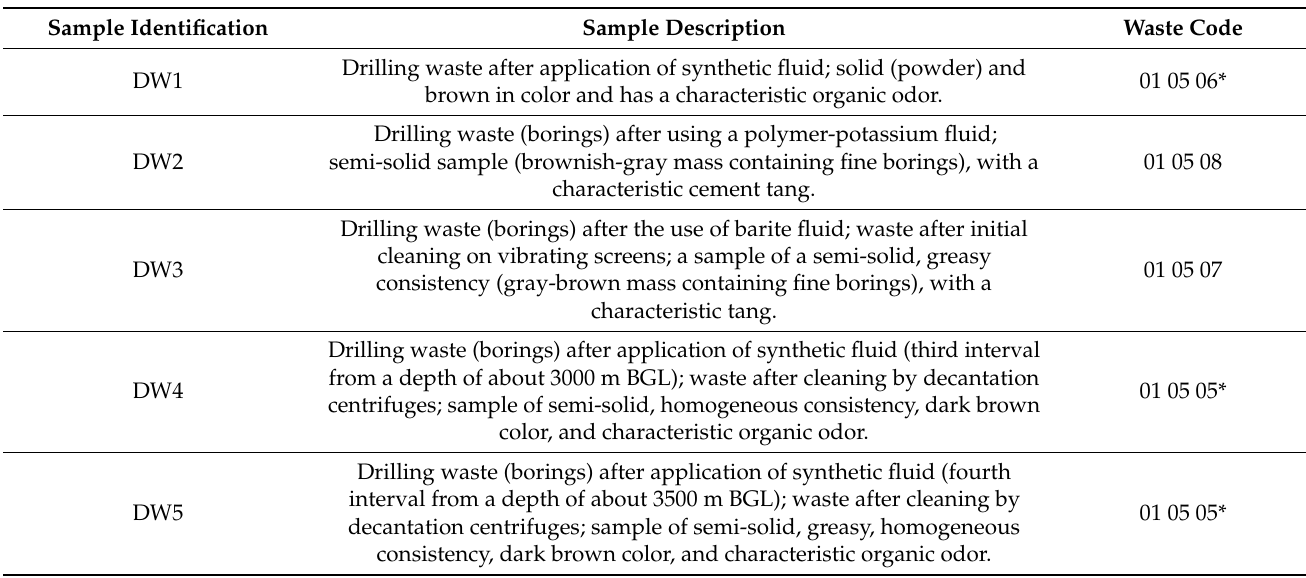
Table 2. Drilling waste sample identification with assigned codes and description of the tested drilling wastes including color, smell, consistency, and a brief description of the drilling method. Sample Identification Sample